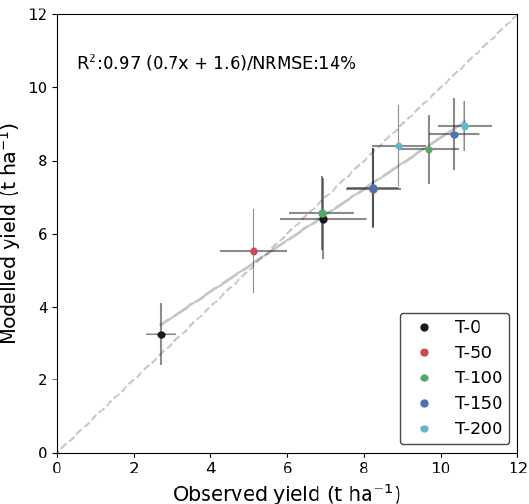
Figure 8. Experiment 3: Comparing DALEC-Crop yield from data assimilation of LAI data to observations for each treatment. The constraint used the multi-year calibration for the 2016–2017 and 2017–2018 seasons with a synthetic EO LAI time-series during the growth stages corresponding to recommended N fertilizer applications in April and May—from the middle of the tillering to stem elongation growth stages (i.e., GS 25 – 35).